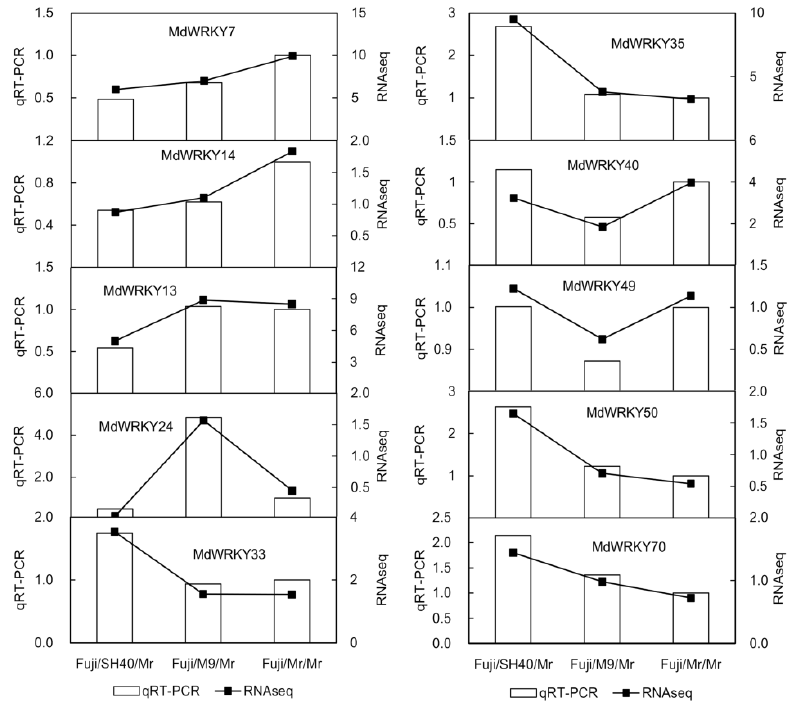
Figure 4. Real-time fluorescence quantitative verification of differentially expressed genes. The bar graph shows the quantitative real-time PCR (qRT-PCR) results, and the line graph shows the expression levels from RNA-seq transcriptome sequencing.